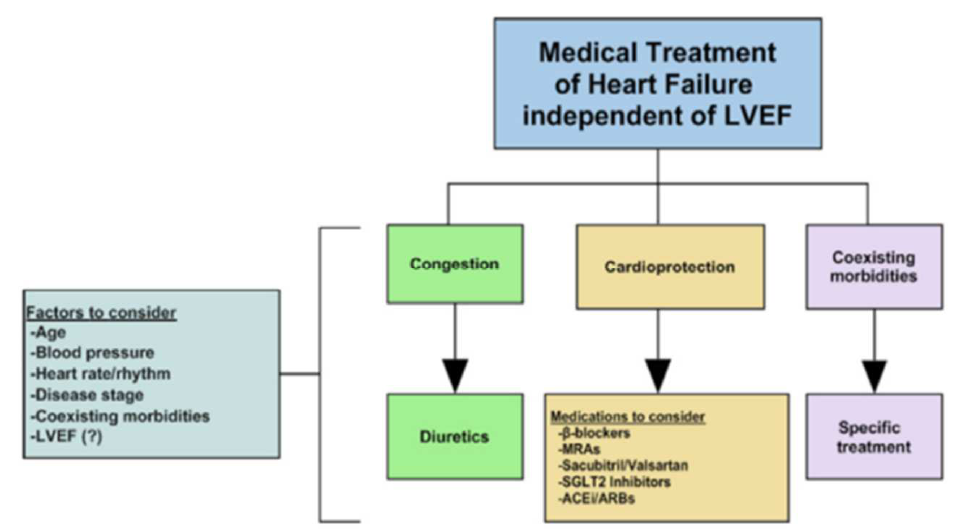
Figure 5. Medical treatment of heart failure (HF) irrespective of left ventricular ejection fraction (LVEF). SGLT2, sodium/glucose cotransporter 2; MRAs, mineralocorticoid receptor antagonists; ACEi, angiotensin-converting enzyme inhibitors; ARBs, angiotensin receptor blockers. Reprinted with permission from Triposkiadis F, Xanthopoulos A and Starling RC. Medical Treatment of Heart Failure: Ignore the Ejection Fraction and Treat All? J. Card Fail. 2021;27:907–909 [50]. Copyright